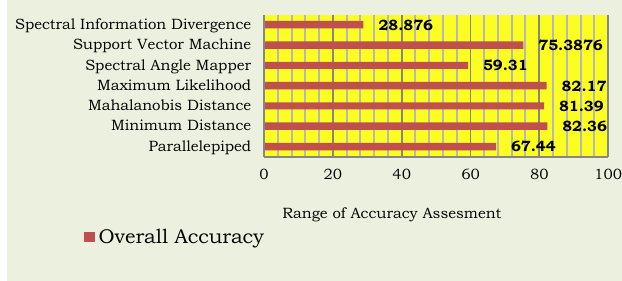
Fig. 16 Comparative barplot of the Overall Accuracy Finally, we have developed a peculiar relation in between the obtained overall accuracy and obtained kappa coefficient for the various classification schemes, this relationship is linear in nature, from this we have also concluded that as the value of kappa coefficient increases the classification accuracy also get increased.